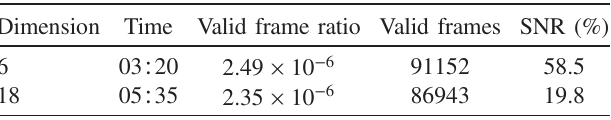
TABLE I. Frame statistics from the best and the least achievable key rate in SUP (time-superposition) basis (see Fig. 3). The valid frame ratio is the ratio of valid frames to all possible frames in the integration time. The signal-to-noise ratio (SNR) is the ratio of valid frames and the coincidence frames which detect a photon in the same